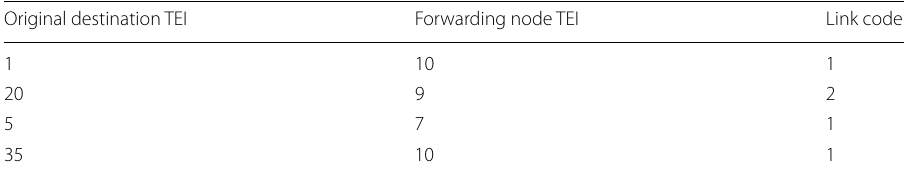
Table 2 The hybrid routing table of node B Original destination